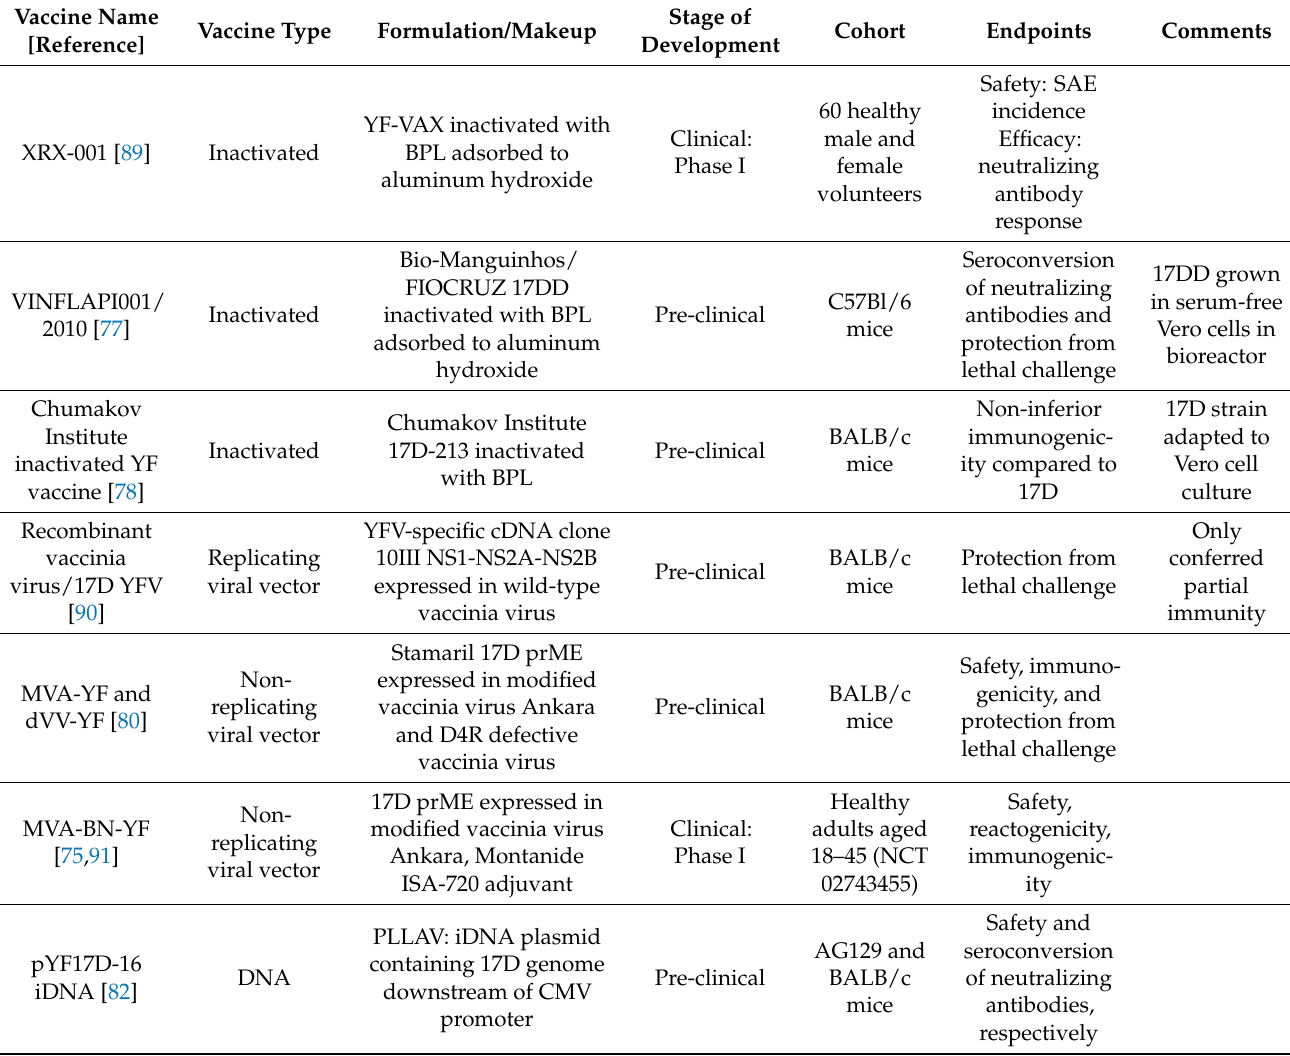
Table 2. Yellow fever vaccine candidates in